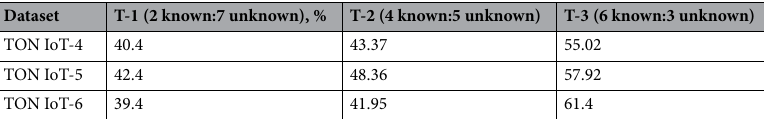
Table 5. Performance on three different testing scenarios.